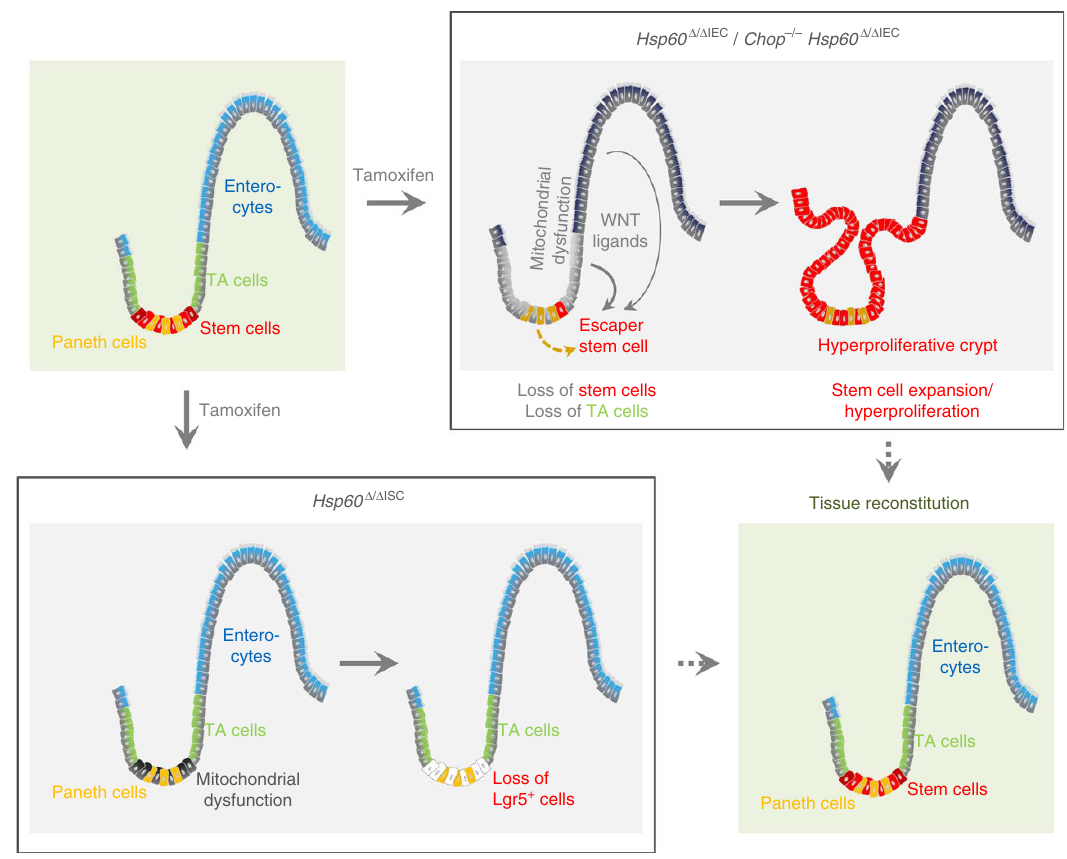
Figure 10 | Schematic model of hyperproliferative crypt formation in Hsp60 D / D IEC mice. Intestinal crypts loose stem cells and the proliferative capacity in response to HSP60 loss. WNT-related factors are produced by HSP60-deficient IEC including Paneth cells to compensate diminished proliferation. This epithelial microenvironment causes HSP60-positive escaper stem cells to hyperproliferate and form HSP60-positive crypt nodules, finally leading to tissue reconstitution. In contrast, HSP60 deficiency in Lgr5-positive stem cells causes transient loss of stem cells without alterations in tissue